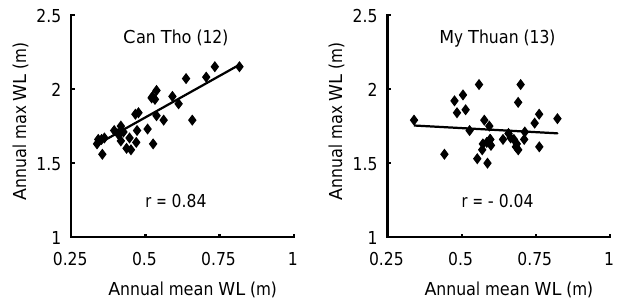
Figure 6. Strong correlation between annual maximum and mean water level at Can Tho, but no correlation at My Thuan; data from 1978 to 2015. The numbers next to the station names refer to the numbers in Fig.